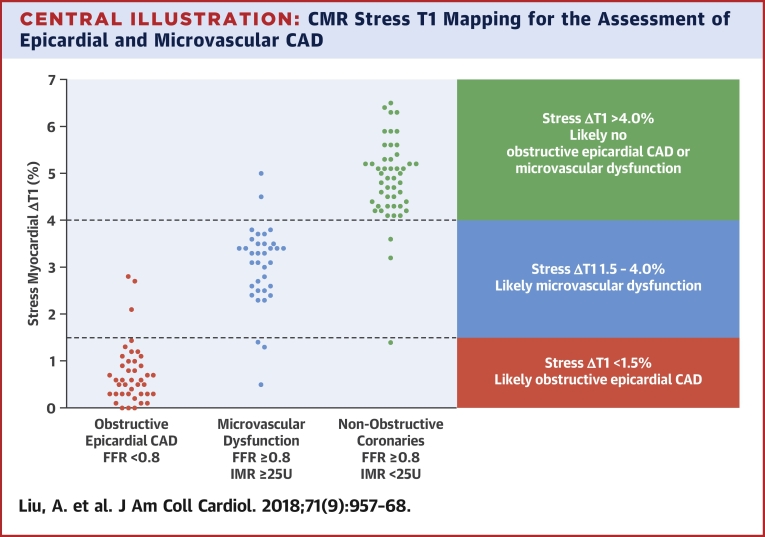
CMR Stress T1 Mapping for the Assessment of Epicardial and Microvascular CADAssessment of epicardial coronary artery disease (CAD) and microvascular dysfunction using gadolinium-free cardiac magnetic resonance (CMR) stress T1-mapping (ΔT1). Each dot represents a noninfarcted coronary artery territory, totaling 125 territories in 60 patients. Obstructive epicardial CAD: 41 vessels in 34 of 60 patients; microvascular dysfunction: 35 vessels in 24 of 60 patients; nonobstructive coronaries: 49 vessels in 33 of 60 patients. Significant obstructive epicardial CAD was defined as fractional flow reserve (FFR) <0.8. Microvascular dysfunction was defined as FFR ≥0.8 and index of microcirculatory resistance (IMR) ≥25 U.